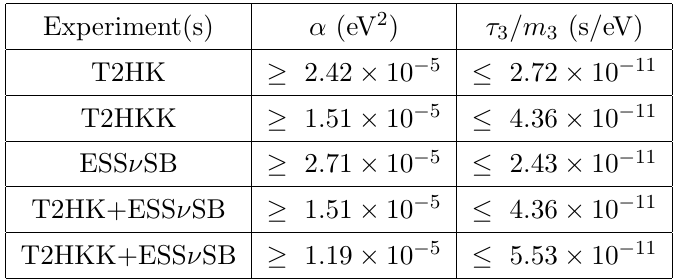
Table 4 . The sensitivity to the decay rate α and the neutrino decay lifetime at 3 σ CL for the standalone experiments T2HK, T2HKK, ESS ν SB and also for the combinations of T2HK+ESS ν SB, T2HKK+ESS ν